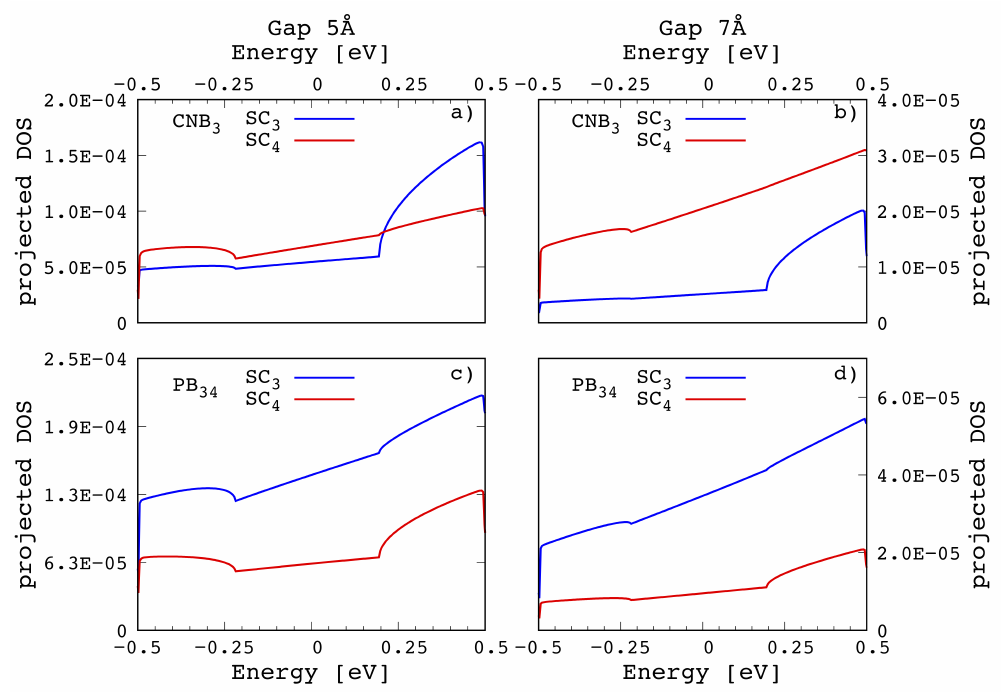
Figure 7. Projected Density of States of the system related to the configurations CNB 3 and PB 34 for two different nano-gap sizes: 5 Å (left) and 7 Å (right). In both cases, the most relevant contribution to the transmission is given by SC 3 and SC 4 . However while SC 3 and SC 4 PDOS maintain the same hierarchy for PB 34 at both the gap sizes, in the CNB 3 this circumstance does not occur and there is a change of